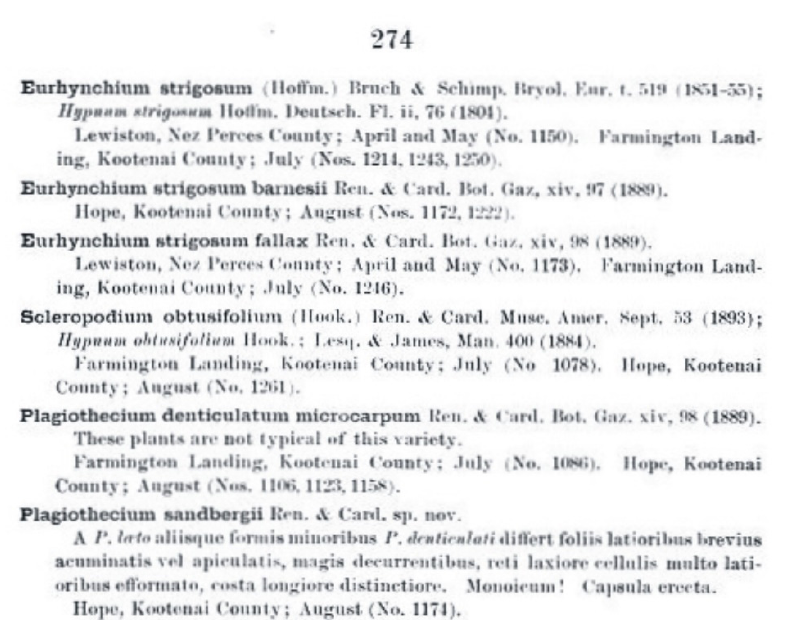
Figure 6. Diagnosis of P . sandbergii Ren. & Cardot [34].